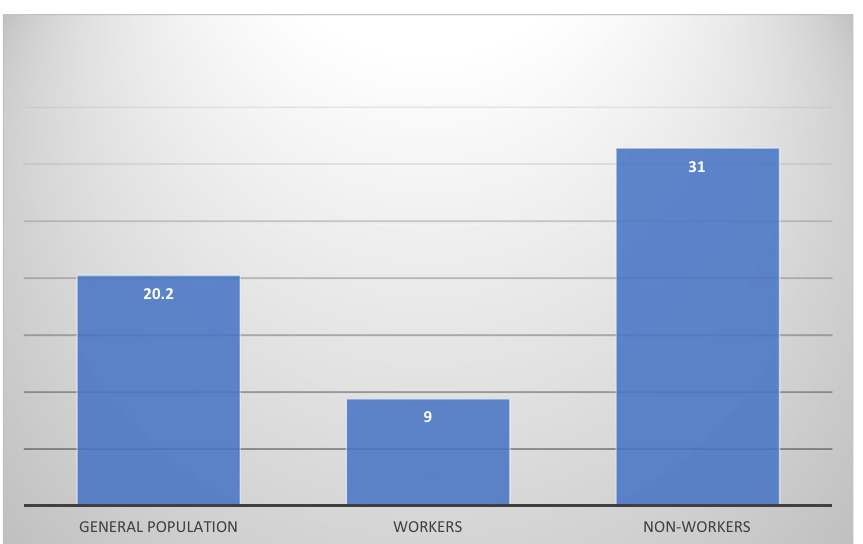
Figure 2. Incidence rate of TB infection per 100,000 among general population, workers and non-workers in Makkah region